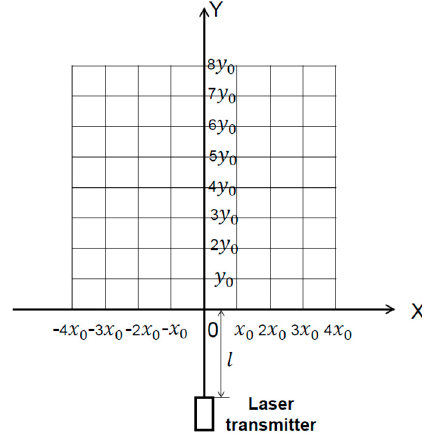
Figure 5. The ideal laser grid image.